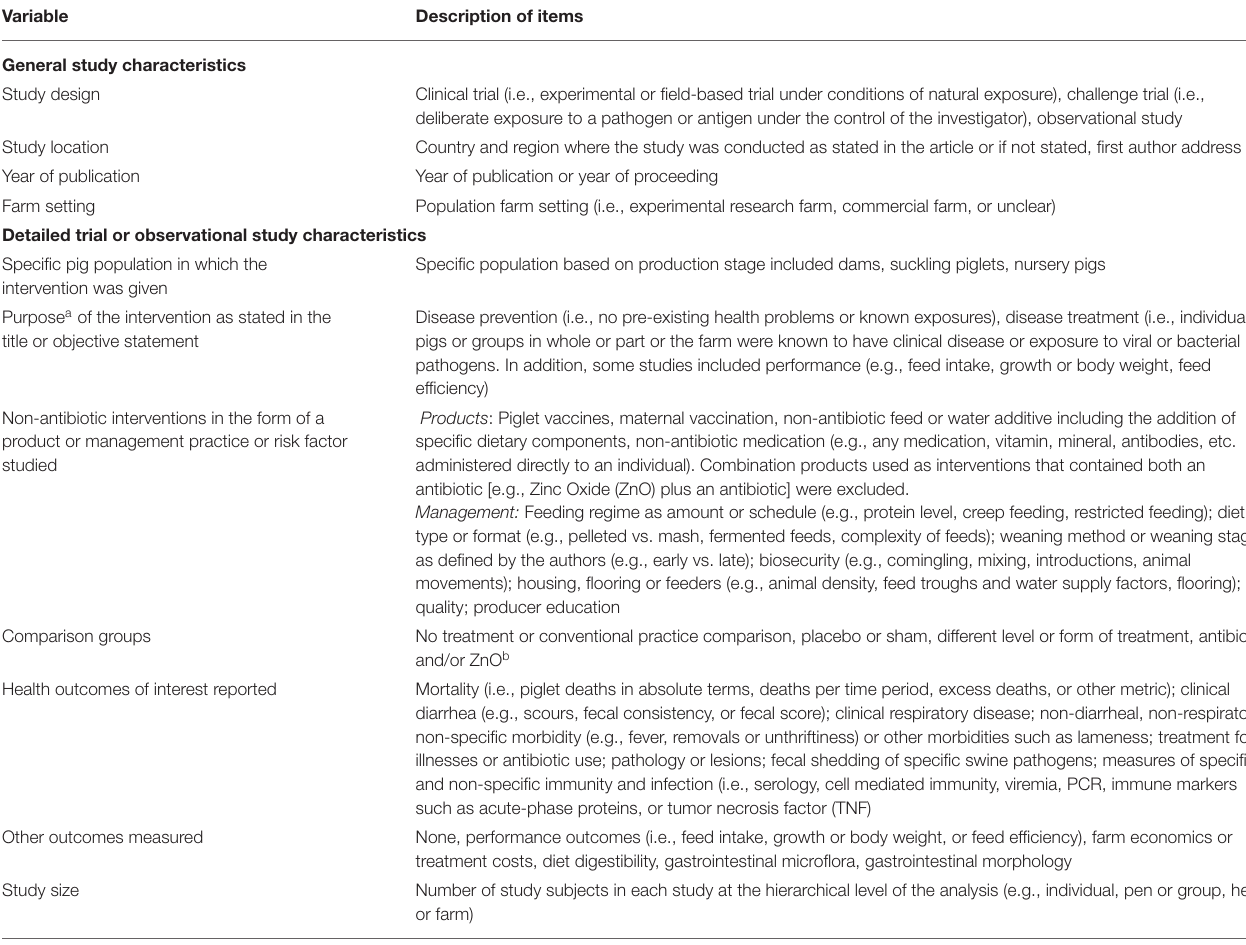
TABLE 3 | Description of data charting items for relevant journal articles, technical reports, proceedings, or theses.